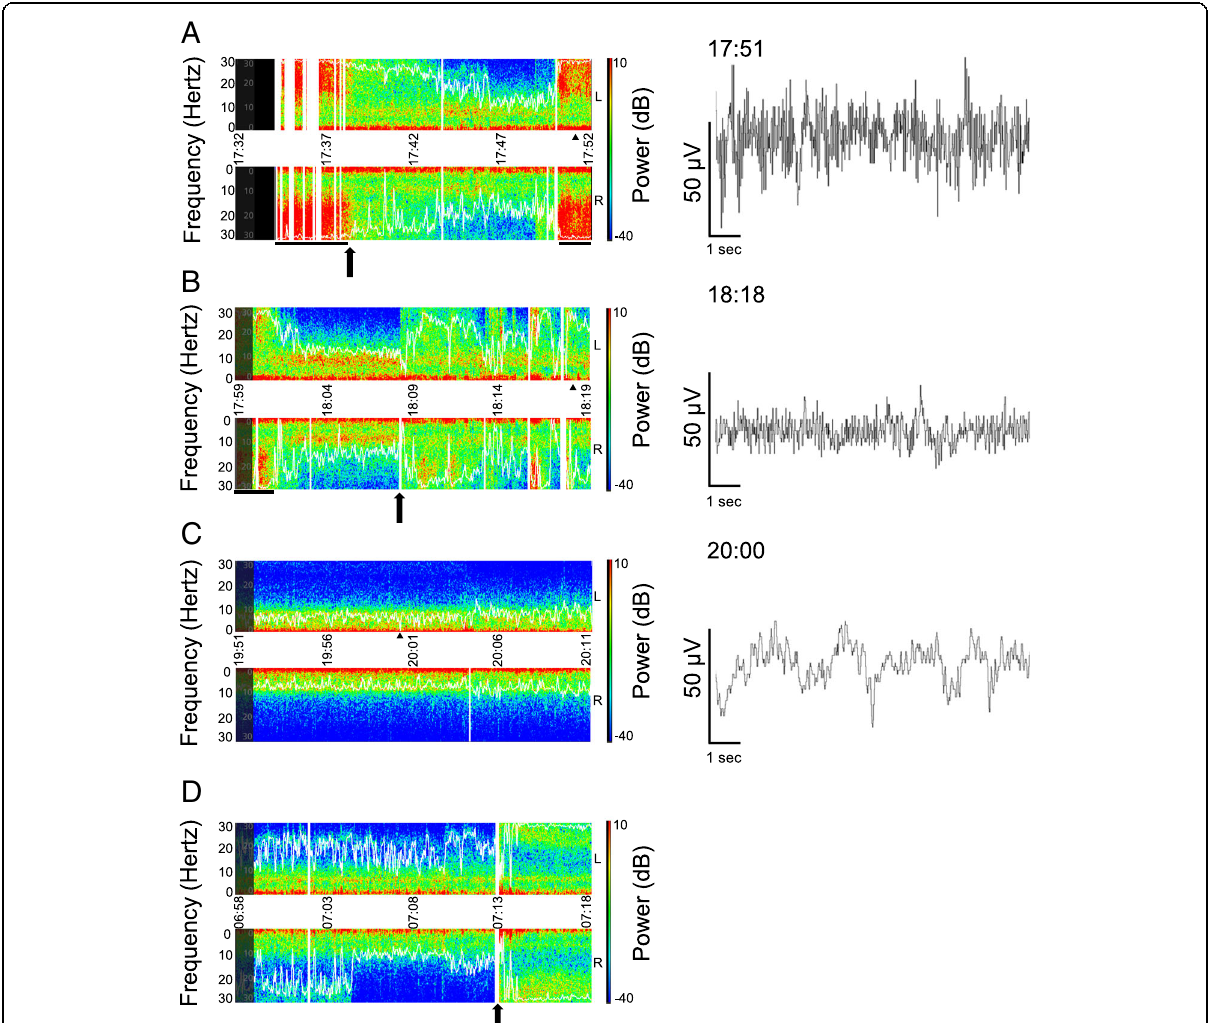
Fig. 1 Screen captures of color density spectral array (CDSA) in the intensive care unit. The upper and lower portions of left panels represent EEG power spectrum obtained from the left and right forehead, respectively. X-axis represents time. Y-axes represent frequency (Hz). The farther from the center horizontal line the higher the frequency. The right vertical line represents power of EEG (dB) where warmer colors represent higher power. White curves represent spectral edge frequency 95%, which is the frequency below which 95% of the spectral power of an EEG resides. Vertical white bars represent missing data on CDSA due to artifacts. Right panels represent 10-s EEG in the left front polar (fp1) region, corresponding to selected time points (black triangle) in left panels. a CDSA immediately after the patient entered the ICU. A black arrow represents the time of administration of diazepam 5?mg iv. Black horizontal bars represent convulsions. b A black arrow represents the start of dexmedetomidine administration. c Approximately 2?h after the start of dexmedetomidine infusion. Patient state index was about 23. d CDSA next morning. A black arrow represents the spontaneous awakening. PSI increased from 40 to 83 in a minute. Corresponding EEG of d could not be downloaded due to a technical failure. Although d shows an asymmetric CDSA, the cause is unknown. Raw EEG waves were illustrated by EDFbrowser 1.64 (https://www.teuniz.net/edfbrowser/; last accessed on February 11, 2019) using “ .edf ” files downloaded from Root®